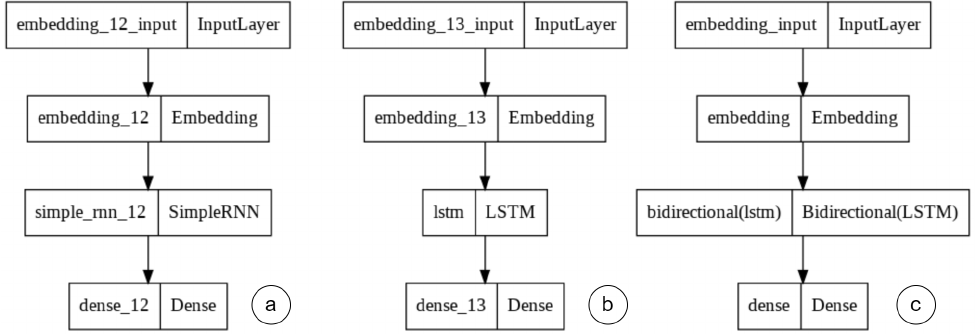
Figure 7. Overview of instantiated models architecture illustrating the ( a ), RNN ( b ), LSTM and ( c ), Bi-LSTM. Table 3. Instantiated models